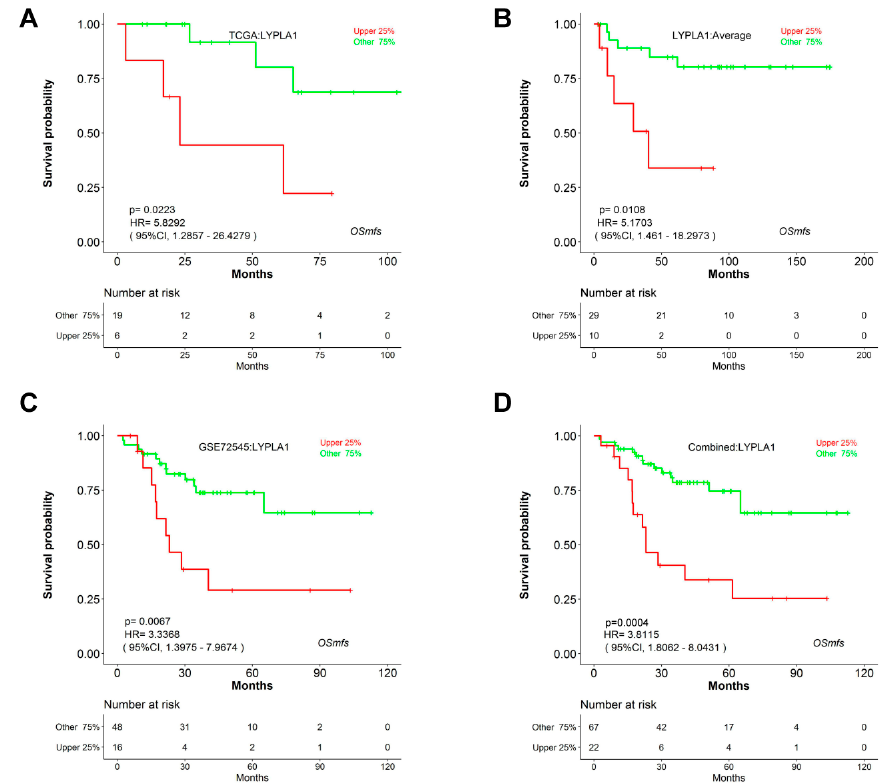
Figure 3. Prognostic analysis of LYPLA1 in OSmfs. The Kaplan–Meier survival analyses of LYPLA1 using data in TCGA ( A ), GSE71118 ( B ) , GSE72545 ( C ) and Combined ( D ) were shown. LYPLA1 displays prognostic significance for MFS patients based on survival analysis of the four cohorts.